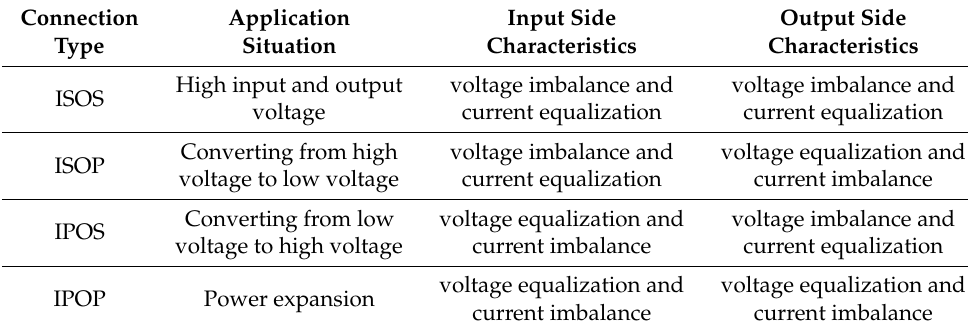
Table 1. Characteristics of different connection